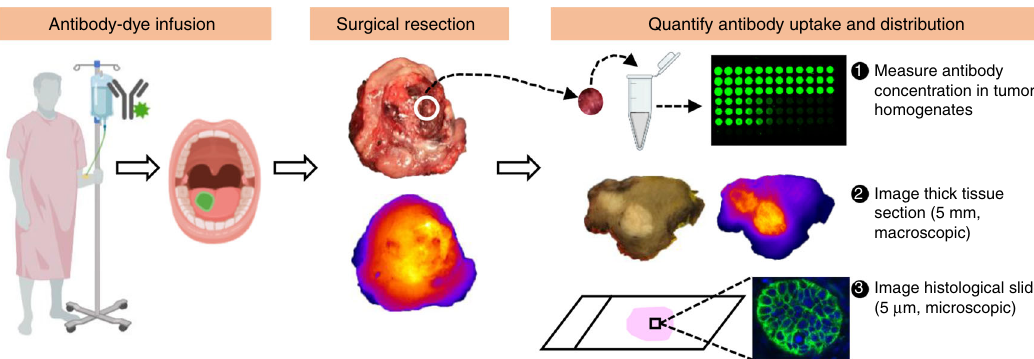
Fig. 1 Overview of the study design. Study patients received infusion of antibody – dye conjugate with or without a loading dose of unlabeled antibody. One to fi ve days post infusion, patients underwent surgical tumor resection. Fresh tissue samples obtained from the primary tumor were homogenized to quantify antibody – dye concentration in the tissue. Whole-tumor specimen were then formalin- fi xed and cut into 5 mm thick tissue sections for macroscopic imaging. Subsequently, 5 µ m histological slides were prepared from each tissue paraf fi n block made from the 5 mm tissue sections for microscopic imaging. Antibody uptake and distribution were measured from tissue homogenates, macroscopic, and microscopic imaging. Some elements of this fi gure were created with BioRender.com.